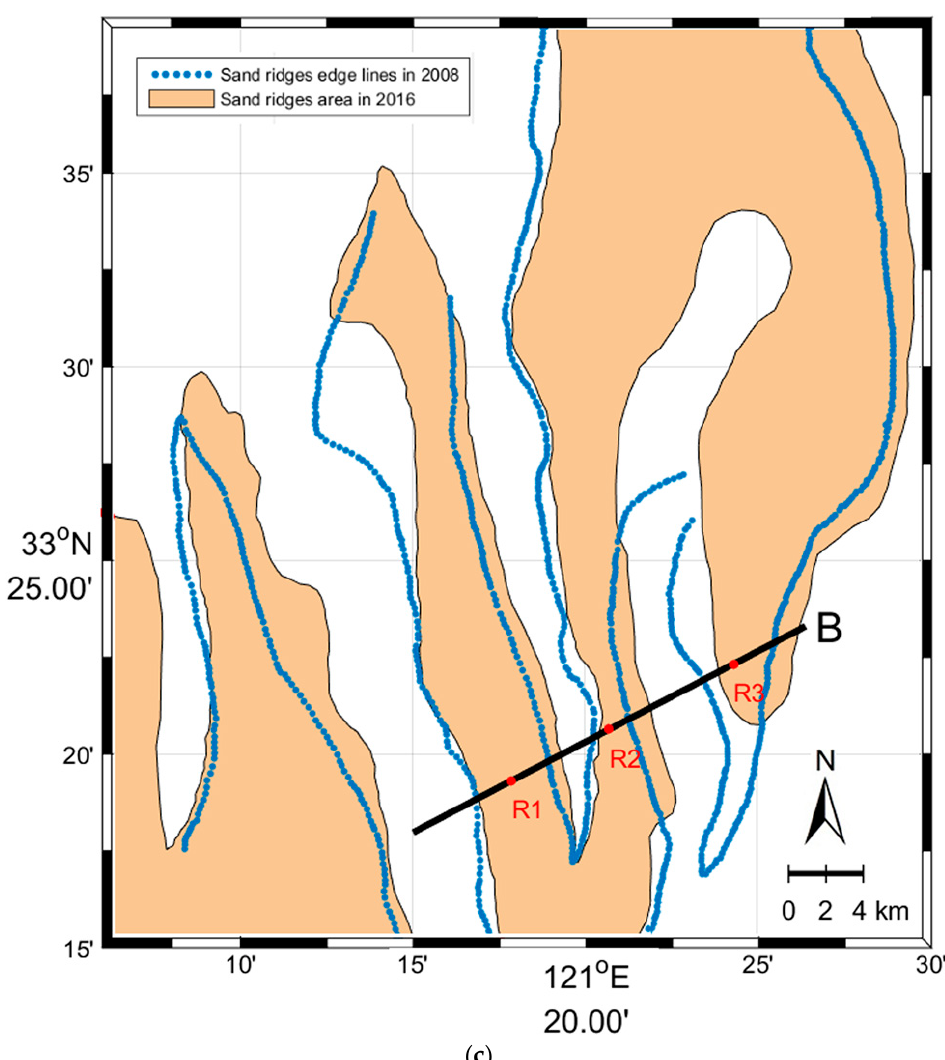
Figure 8. Landsat images over Subei Bank: ( a ) Landsat_7 ETM+ image acquired at 02:20:53 UTC on 24 April 2008; ( b ) Landsat_8 OLI image acquired at 02:30:41 UTC on 18 February 2016; and ( c ) the edge of the sand ridges in the study area (yellow dashed box in ( a , b )) extracted from Landsat images. The dotted blue line denotes the edge extracted from ( a ) in 2008, and the light brown patch denotes the sand ridge area extracted from ( b ) in 2016. The field survey along cross section B is the same as that in Figure 1b with R1, R2, and R3 representing the locations of the sand ridge crests measured in 2016.